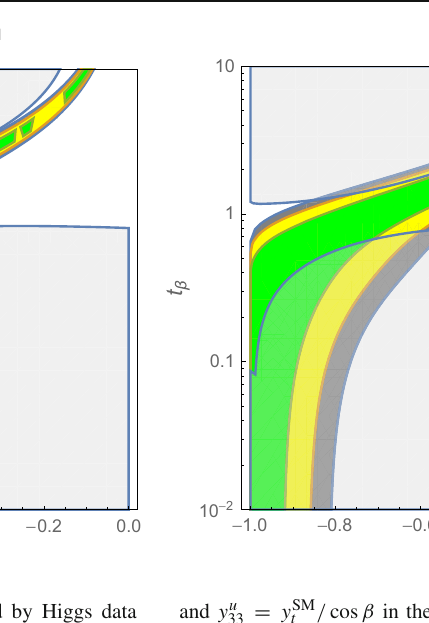
Fig. 3 Parameter space for sin α and tan β allowed by Higgs data within 1 σ (green), 2 σ (yellow), and 3 σ (dark gray). The gray regions corresponds to the unitarity and stability bounds. y u